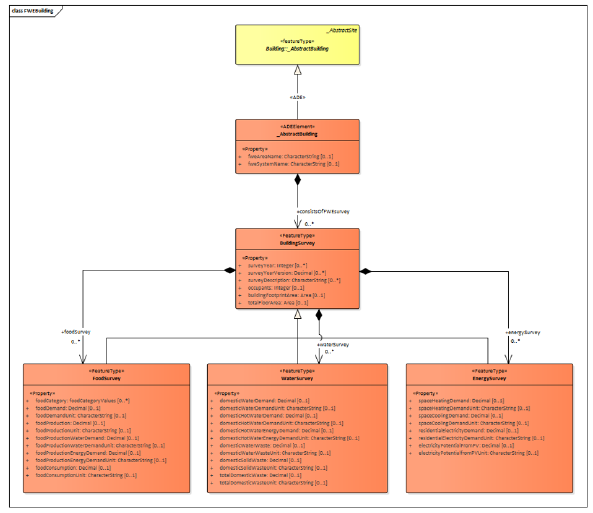
Figure 4. The UML class diagram for FWEBuilding